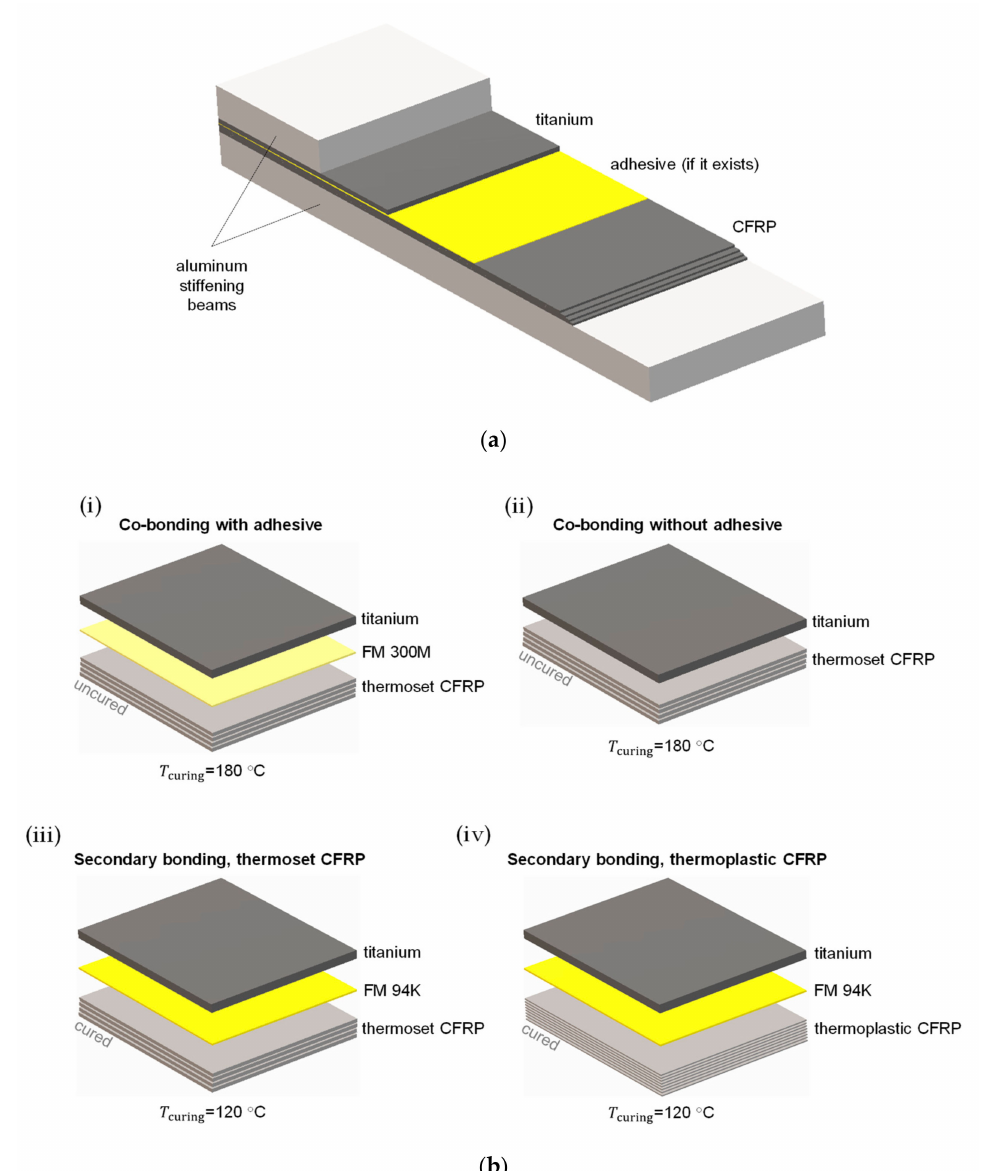
Figure 1. Schematic of the titanium–CFRP adhesive joint under study. ( a ) The primary joint between the titanium and CFRP is sti ff ened by two aluminum beams (sketch presented in scale), reproduced from [19], with permission from Elsevier, 2020. ( b ) A schematic presentation of the four manufacturing options (MOs) under consideration: (i) MO 1, (ii) MO 2, (iii) MO 3, and (iv) MO